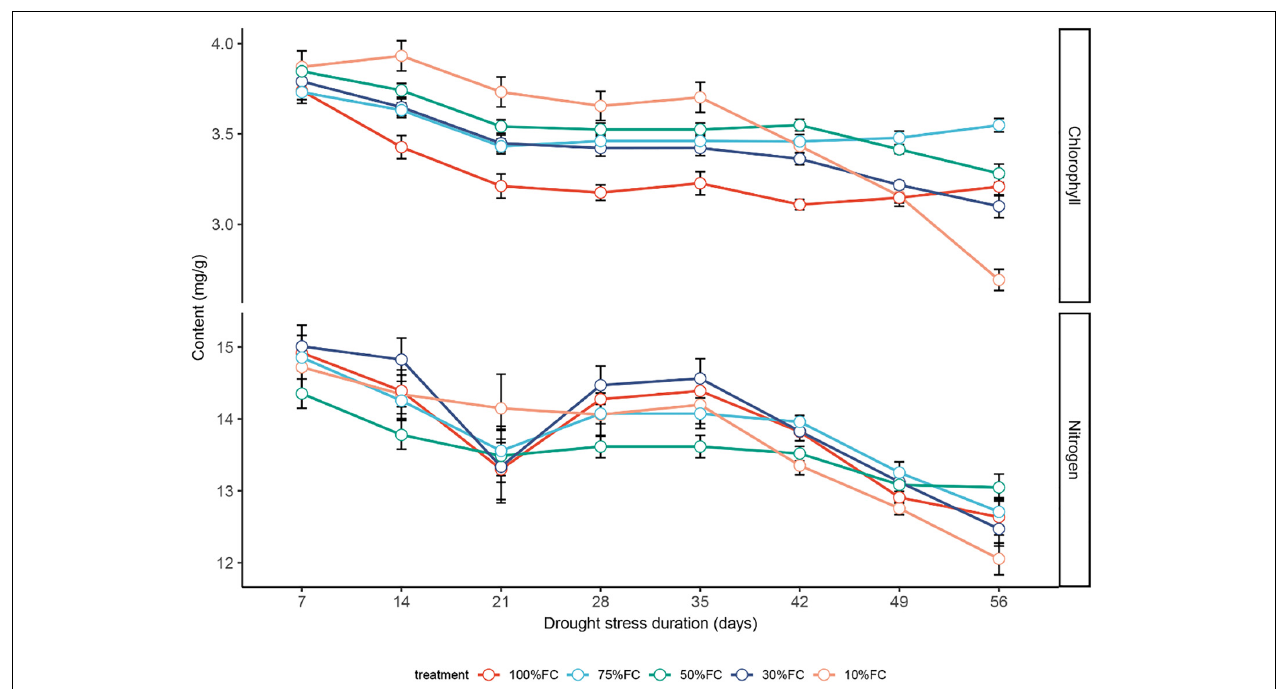
FIGURE 4 | The effect of drought stress treatments on chlorophyll and nitrogen contents in leaves of T. sinensis leaves. The data represent the average of the spectrum inversion results under each treatment, and data are reported as the mean ± SE.